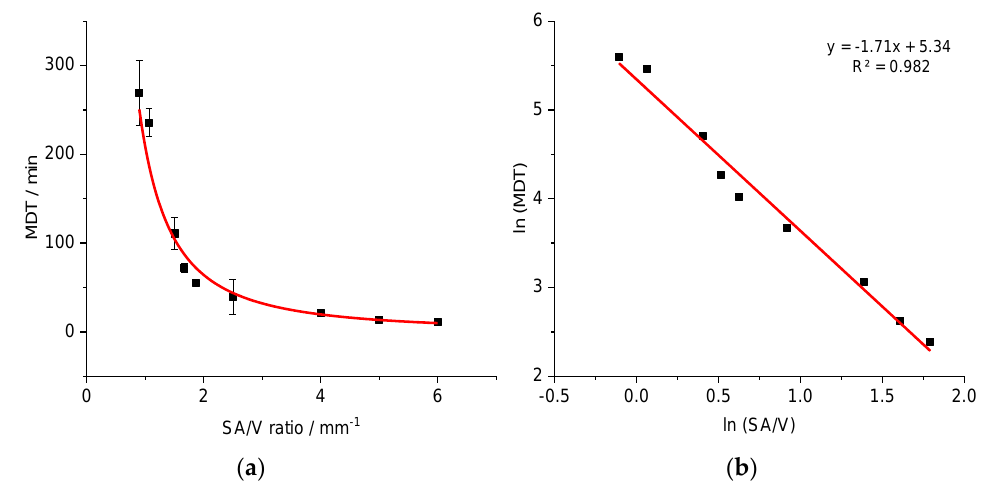
Figure 4. Correlation of MDT and SA/V ratio for the EVA-LD formulation ( a ) and linearized version ( b ) ( n ≥ 3; x ± s). Table 5. Comparison of MDT: predicted vs. experimental data of the EVA-LD formulation ( n ≥ 3; x ± s).